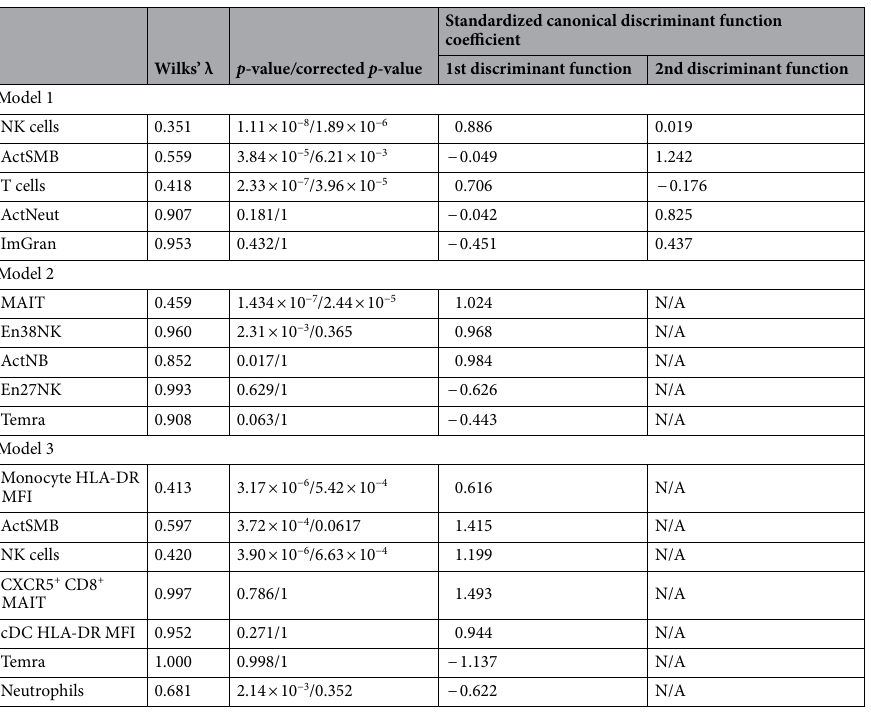
Table 2. Optimized multivariate immune profiles for predicting COVID-19 disease severity using discriminant analysis. Discriminant models were constructed to distinguish between healthy volunteers, moderately ill patients, and severely ill patients (Model 1); healthy volunteers and COVID-19 patients presenting with moderate or severe disease (Model 2); or moderately ill and severely ill COVID-19 patients (Model 3). Model variables are listed in the order they were incorporated into the model. Correction for multiple testing was performed using Holm method 60 . NK cells natural killer cells, en27NK CD27 + NK cells, en38NK CD38 + NK cells, actNeut activated HLA-DR + neutrophils, imGran Ki67 + immature granulocytes, Temra CD27 − CD45RA + effector memory CD8 + T cells, actNB CD21 + CD27 − Ki67 + B cells, actSMB CD21 − CD27 + CD38 lo B